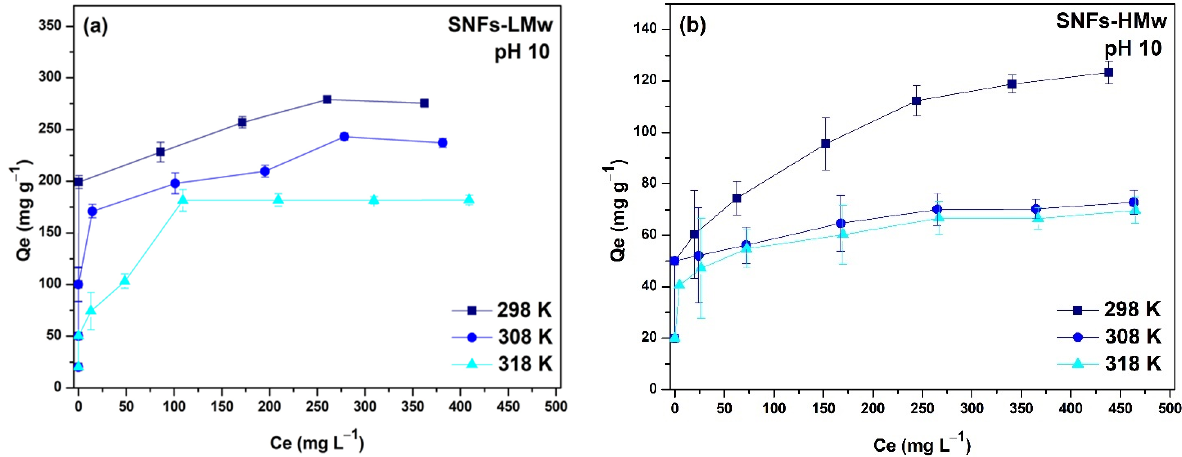
Figure 5. Effect of initial MB concentration and temperature: ( a ) SNFs-LMw and ( b ) SNFs-HMw. Error bars represent standard deviations of triplicate tests.